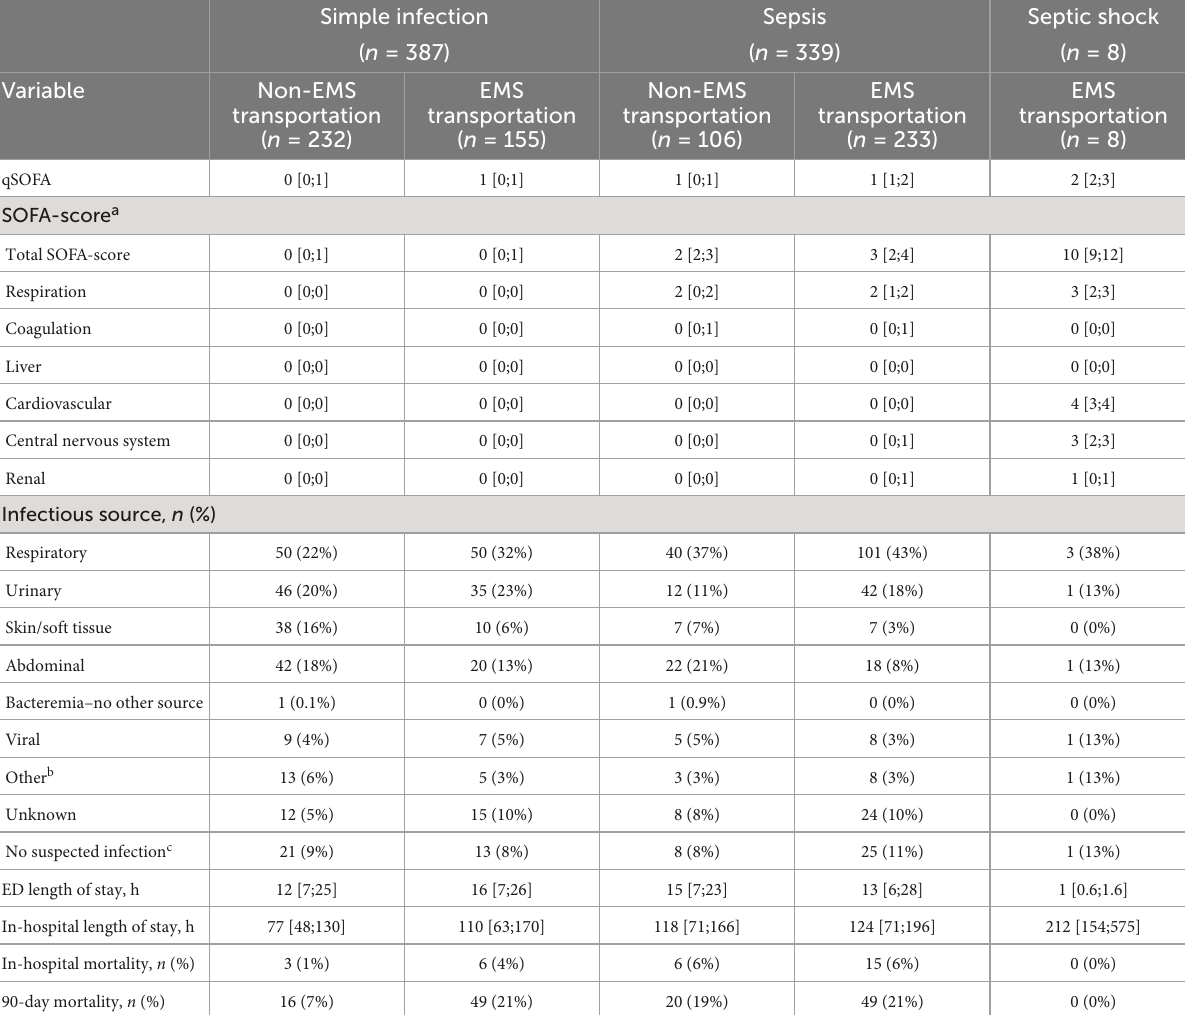
TABLE 2 Baseline characteristics of patients admitted minimum 24 h with fluids